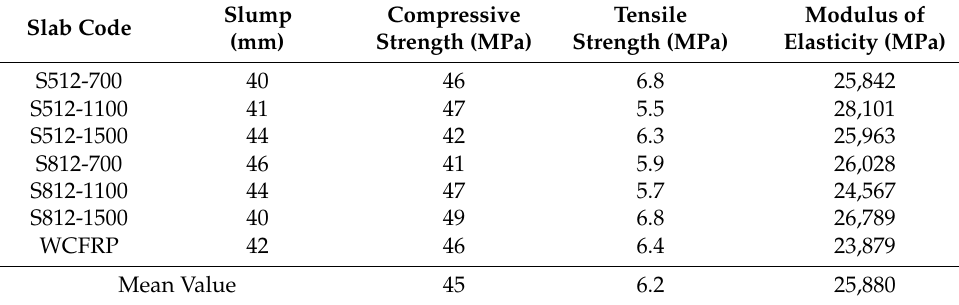
Table 6. Fresh and hardened properties of concrete